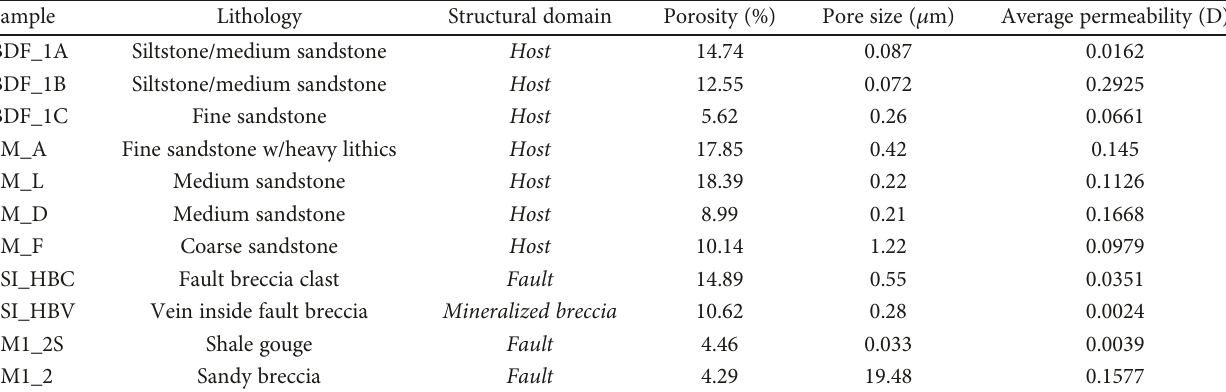
Table 3: Table of average porosity, and pore size of the 7 main facies and 2 faults that produced di ff erent types of fault core along the same plane.